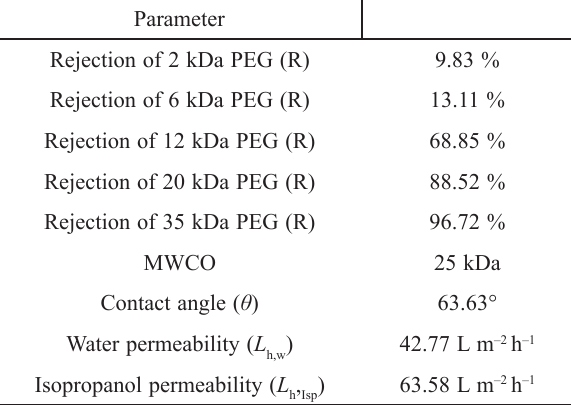
Table 1 – Characteristics of the synthesized PES membrane Parameter